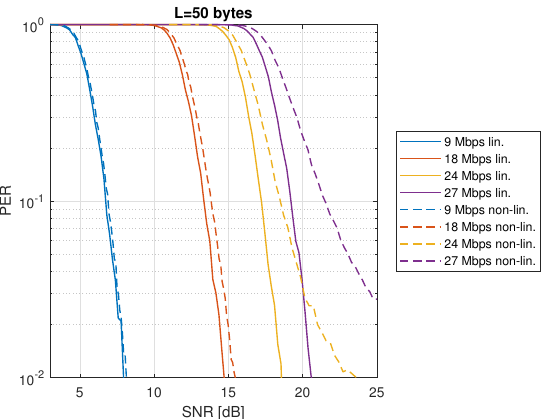
Figure 3. PER vs. SNR with linear and non − linear HPA (IBO = 6 dB, L = 50 bytes).